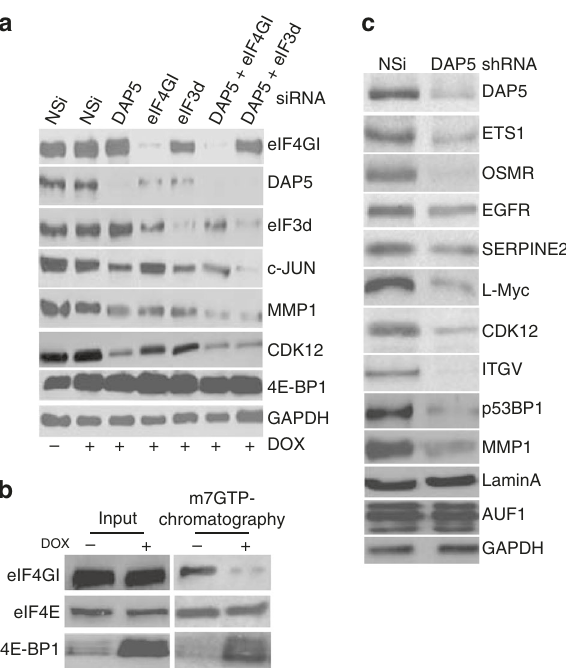
Fig. 5 DAP5 and eIF3d are both required for translation of DAP5-dependent mRNAs. a Overexpression of 4E-BP1 by stable cDNA transformation in MDA-MB-231 cells silenced with siRNAs: non-silencing (NSi), DAP5, eIF4GI, eIF3d, DAP5 + eIF4GI, and DAP5 + eIF3d. b Cap chromatography of cell lysates with or without 4E-BP1 cDNA overexpression. Representative immunoblots show almost total sequestration of eIF4E by overexpressed 4E-BP1. c Representative immunoblots of MDA-MB-231 cells silenced with NSi or DAP5 siRNAs as in ( a ) probed for proteins whose mRNAs were found to be reduced in polyribosomes by DAP5 silencing (Table 1). Lamin A, AUF1, and GAPDH served as DAP5-independent controls. Results